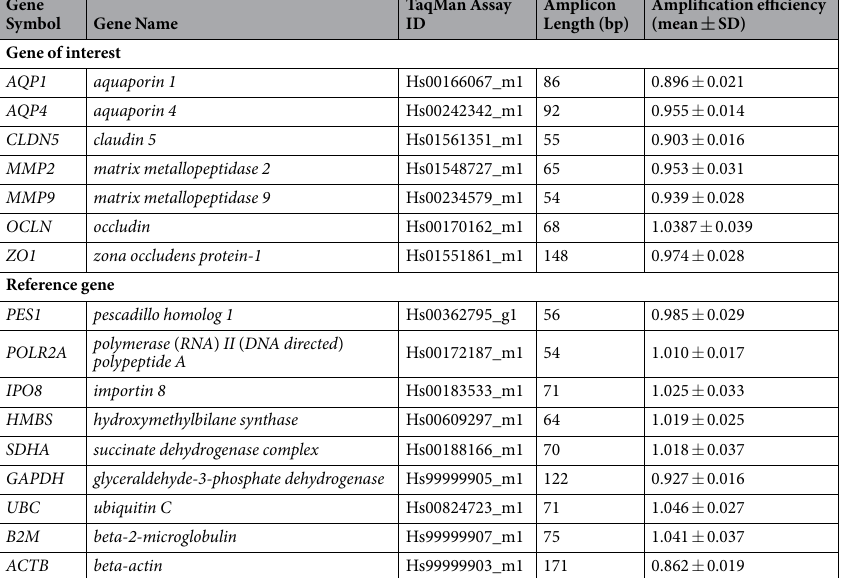
Table 2. Introduction of the PCR primers and probes. “_m” indicates the assay’s probe spans an exon junction and will not detect genomic DNA. “_g” indicates the assay may detect genomic DNA. Detailed information for each TaqMan Assay is available from Applied Biosystems.